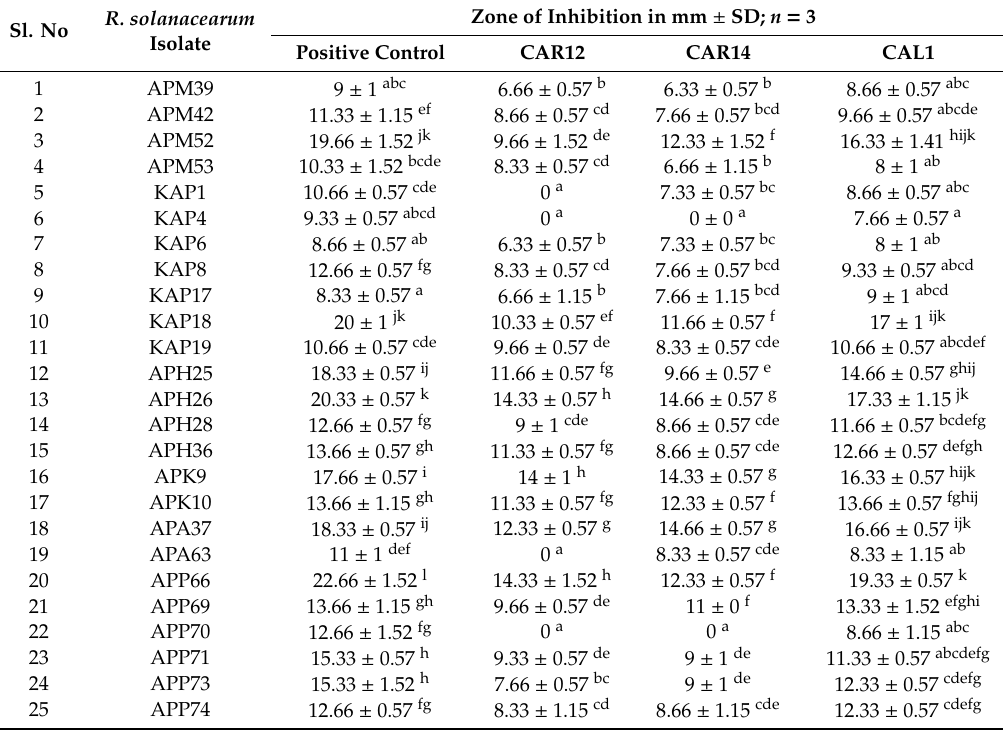
Table 4. Antimicrobial activity of fungal siderophores on Ralstonia solanacearum isolated from infected groundnut plants.